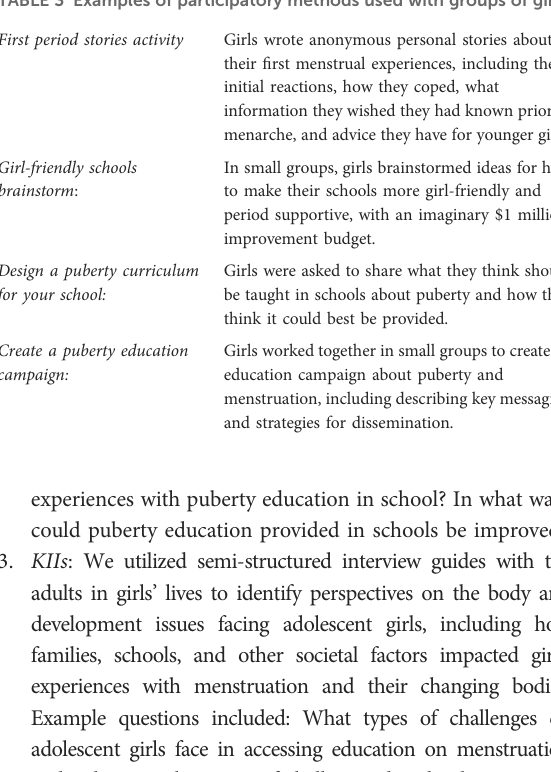
TABLE 3 Examples of participatory methods used with groups of